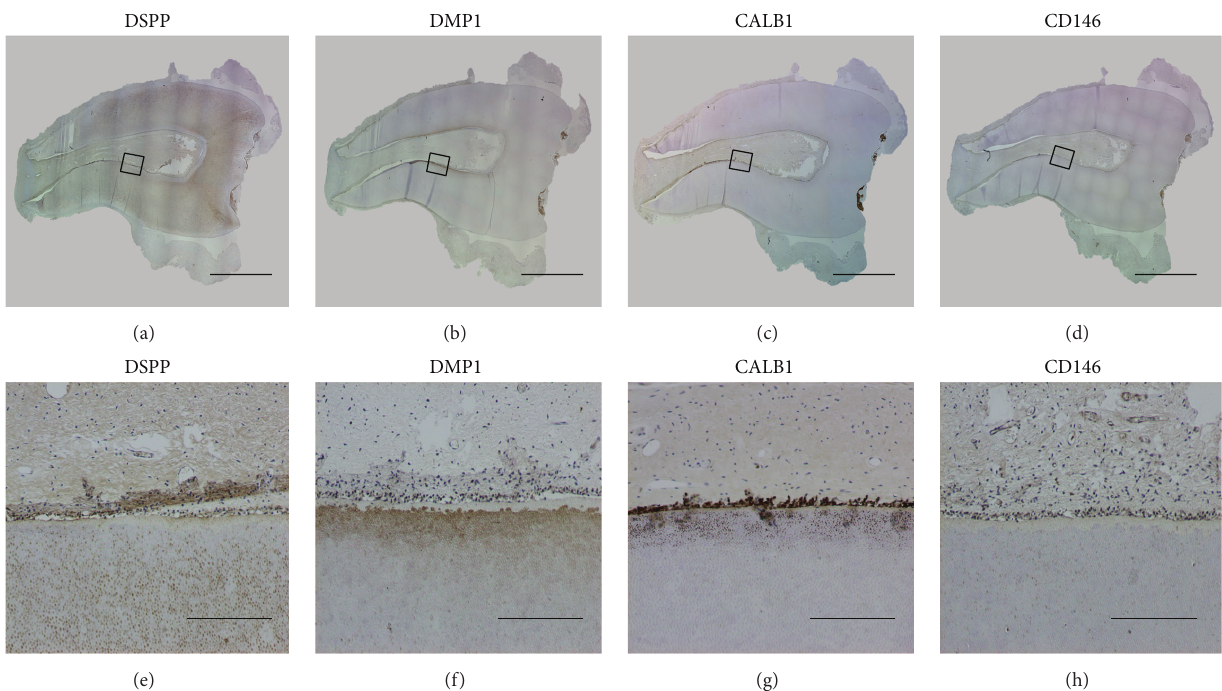
Figure 4: Immunohistochemical (IHC) staining of dental pulp tissue. IHC staining for DSPP (a, e). DSPP was noted in pulpal tissue, the odontoblast layer, and primary and secondary dentin. IHC staining for DMP1 (b, f) and CALB1 (c, g). CALB1 was especially expressed in pulpal tissue and the odontoblast layer. IHC staining for CD146 (d, h) (scale bars: (a)–(d) 4mm, (e)–(h) 200 𝜇